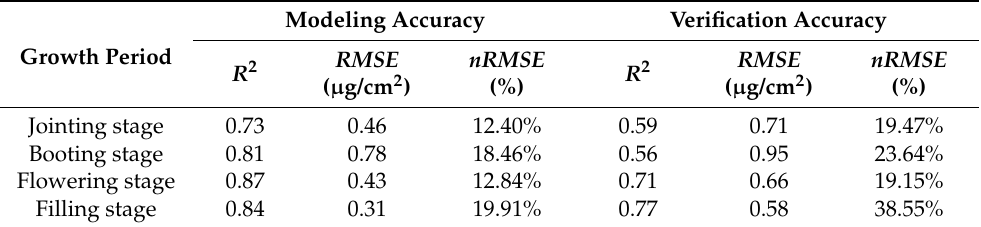
Table 3. Optimal subset regression modeling results of leaf area index estimation based on wavelet energy coefficient at different growth